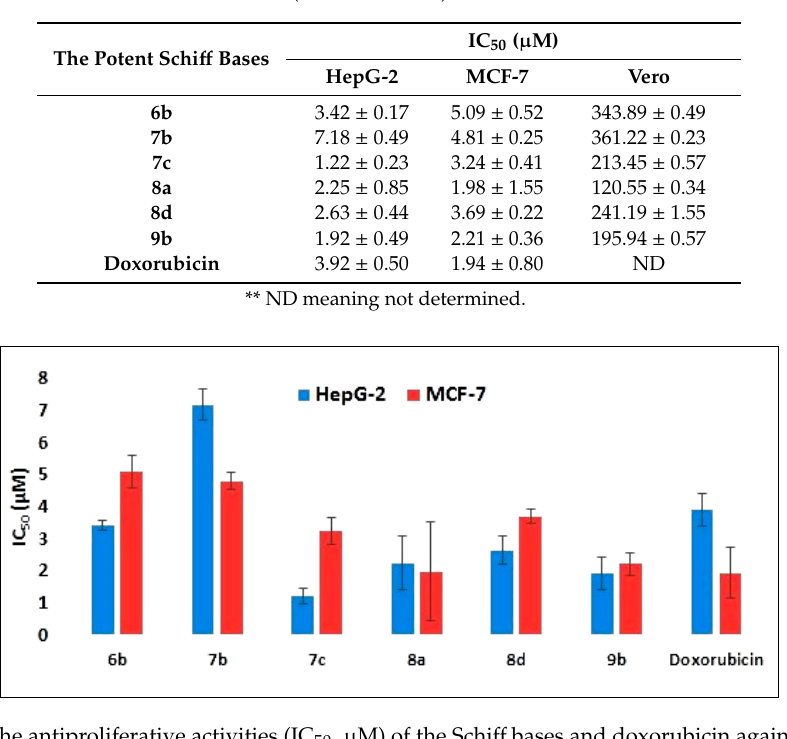
Table 5. Intracellular killing activities of Schiff bases.